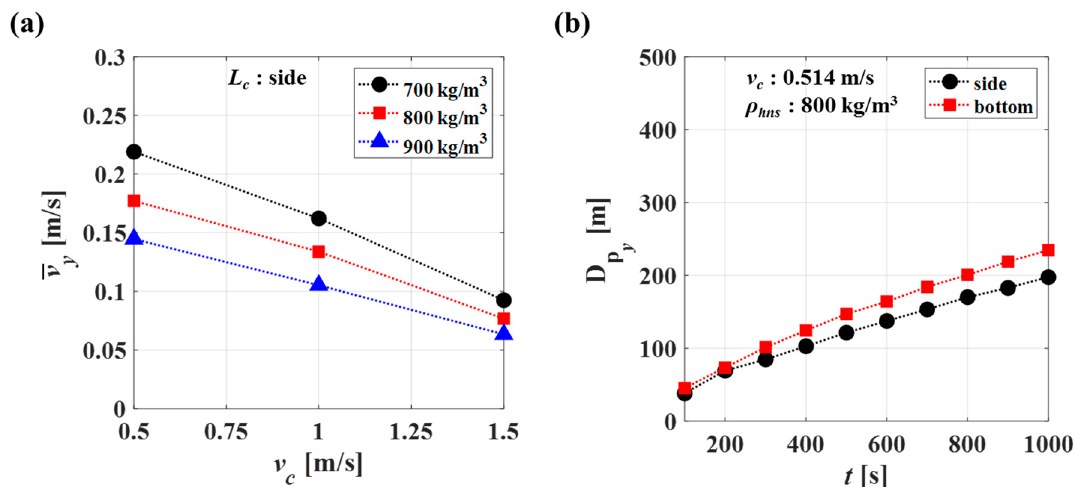
Figure 6. ( a ) Transverse propagation velocity of the HNS for the input variables and ( b ) difference of max propagation distance in the transverse direction between the cases of the side crack and bottom crack.